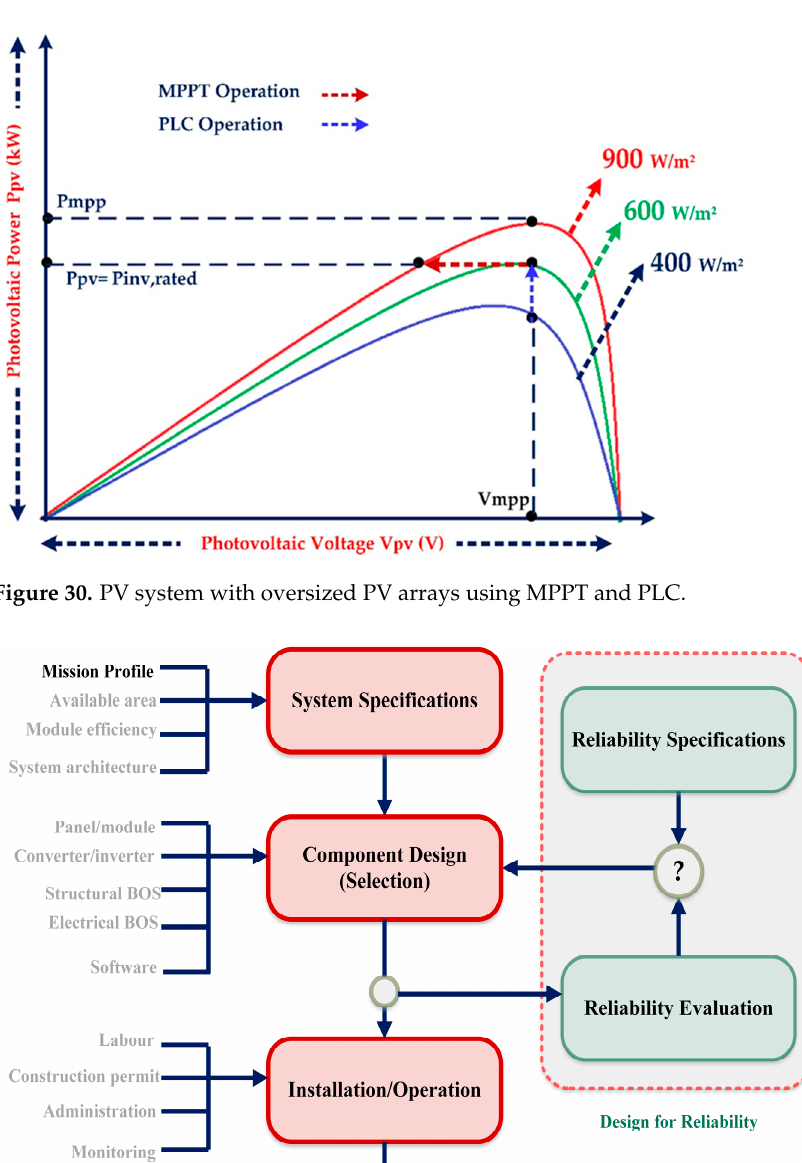
Figure 29. Extraction of Power generation with oversized PV arrays.